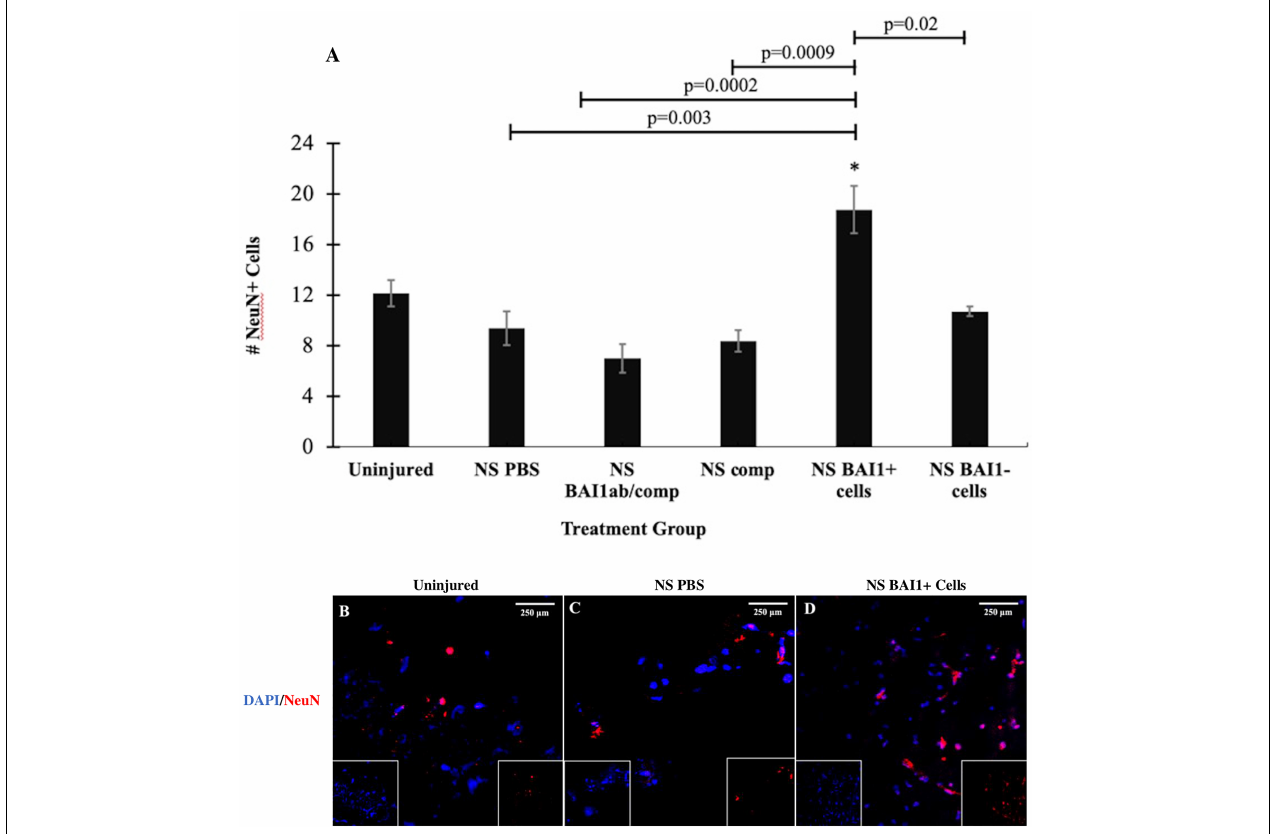
FIGURE 4 | Comparison of the number of NeuN+ neurons before and after NS injury and with depletion or addition of BAI1+ cells. Six tissue sections from 3 to 6 animals per treatment group were stained with TUNEL reagents (red in B–D ). Nuclei were stained with DAPI (blue in B–D ). NeuN positive cells were counted within a 1 mm area lateral to NS tract or in a similar area in the uninjured brain. The results are the means ± SEM 24 h after NS with injection of PBS, the BAI1 mAb and complement (BAI1ab/comp), complement alone (comp), BAI1+ cells or BAI1– cells (A) . The elevation in the number of NeuN cells in brains injected with BAI1+ compared to the uninjured brain was not statistically significant ( p = 0.06). The number of NeuN+ cells was significantly greater after injection of BAI1+ cells than in the other treatment groups ( ∗ p < 0.05). Panels (B–D) are photographs of NeuN and DAPI Unmerged images are shown as insets at the bottom of the photographs of merged